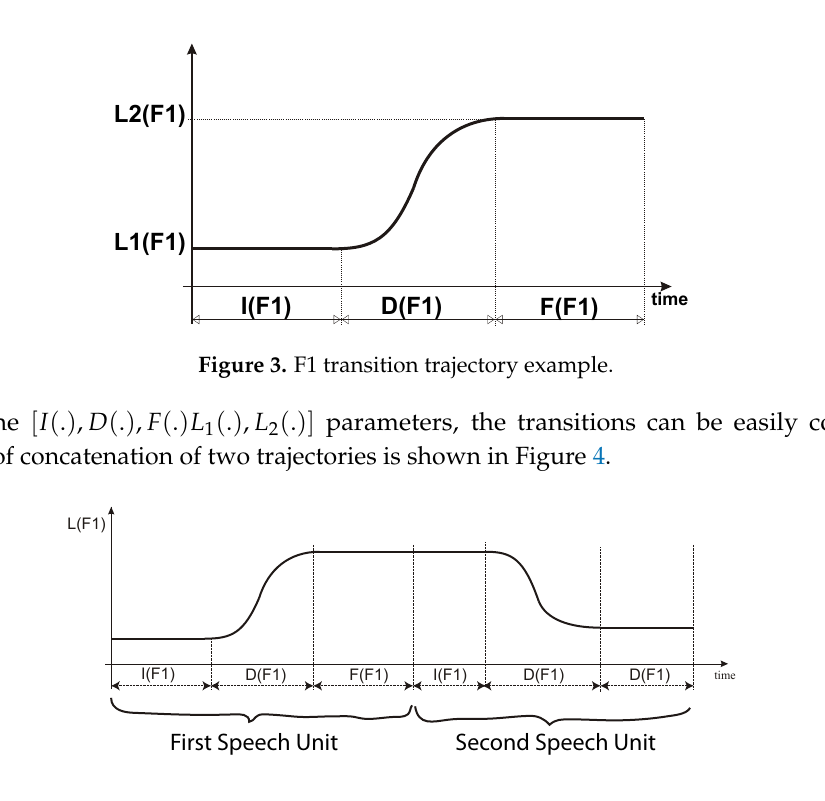
Figure 4. Formant trajectories concatenation example.